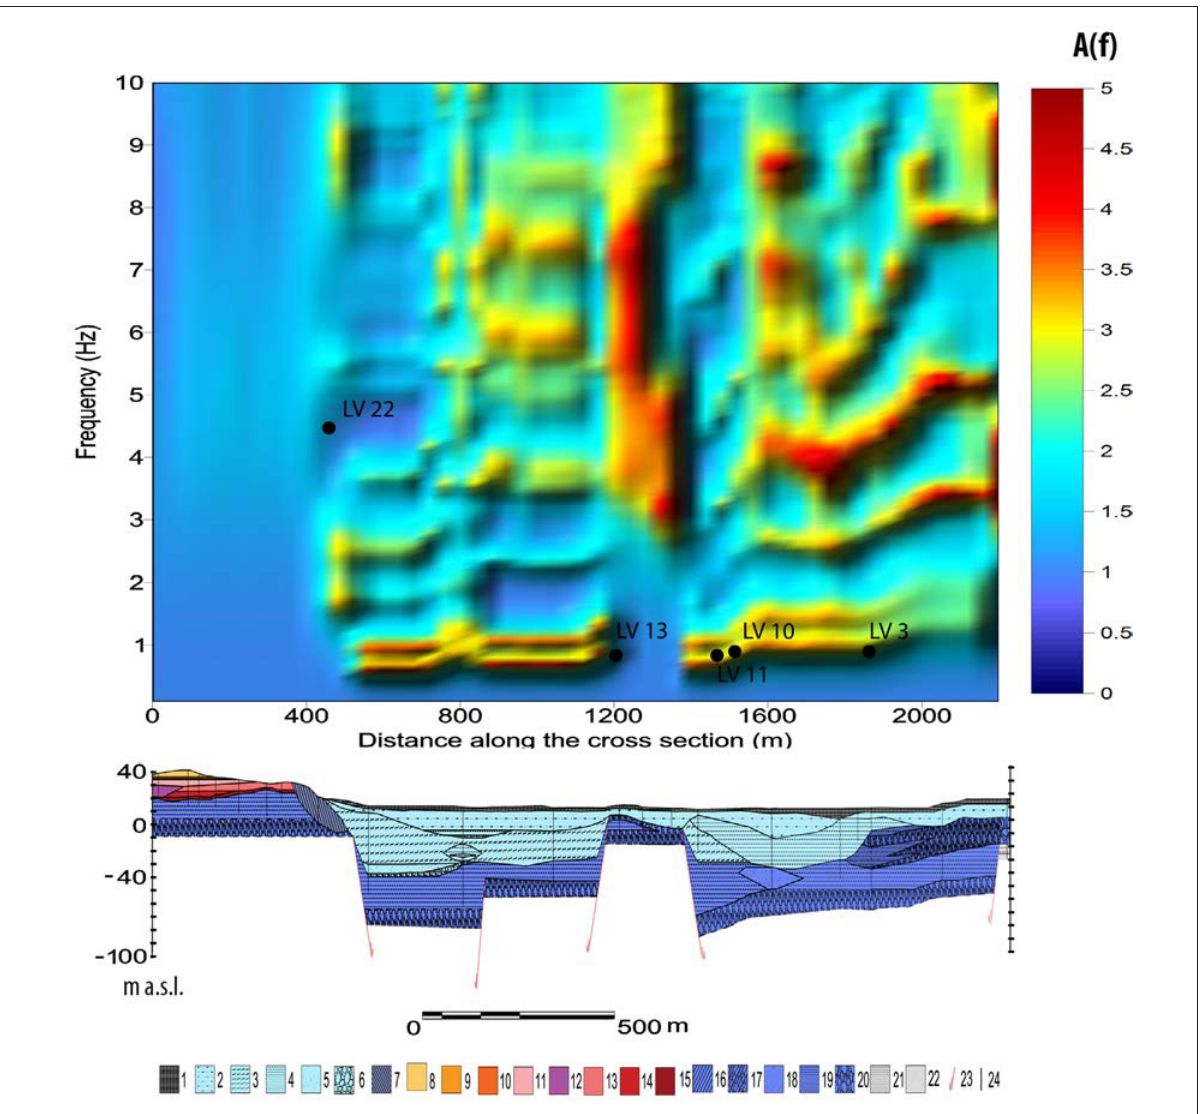
Figure 13. 1D A(f) distribution (top) along the route of Via Laurentina (bottom). See Figure 4 for the key to the legend. Location of noise x measurements along the route (and related first H/V peak) is also